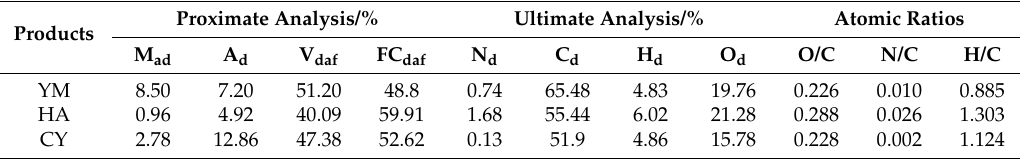
Table 1. Proximate and ultimate analyses of raw coal, residual coal, and HA.